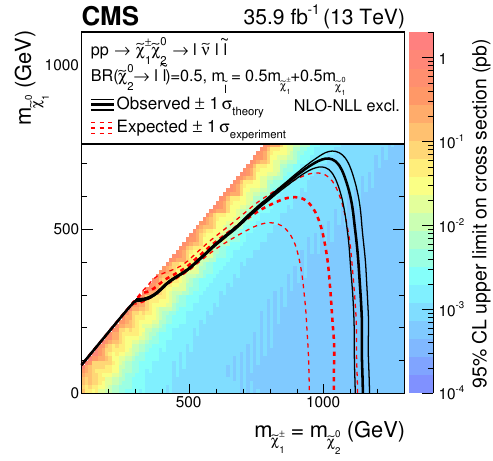
Figure 14 . Interpretation of the results in the (cid:13)avor-democratic model with mass parameter x = 0 : 5 obtained with events of category A. The shading in the m indicates the 95% CL upper limit on the chargino-neutralino production cross section. The contours bound the mass regions excluded at 95% CL assuming the NLO+NLL cross sections. The observed, (cid:6) 1 (cid:27) (cid:6) 1 standard deviation of the theoretical cross section) observed, median expected, and theory ( (cid:6) 1 (cid:27) experiment expected bounds are